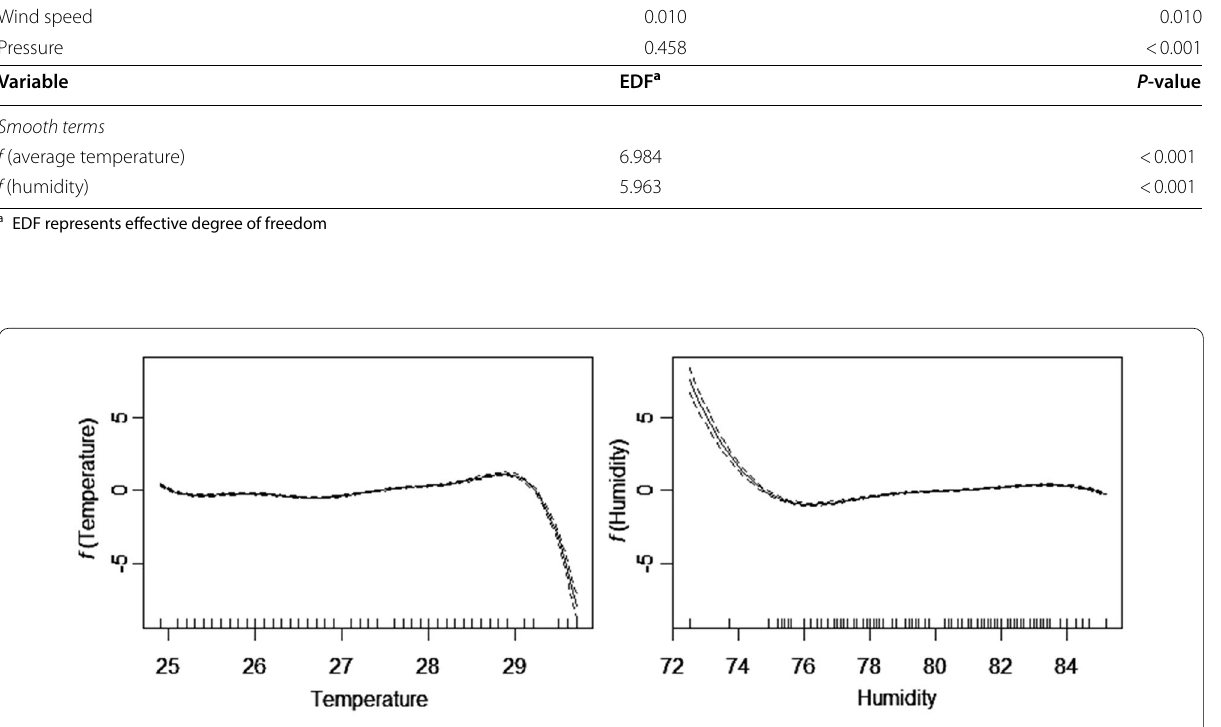
Fig. 3 Estimated smooth curves (solid line) from GAM for average temperature (left panel) and average humidity (right panel). The dashed lines denote 95% confidence